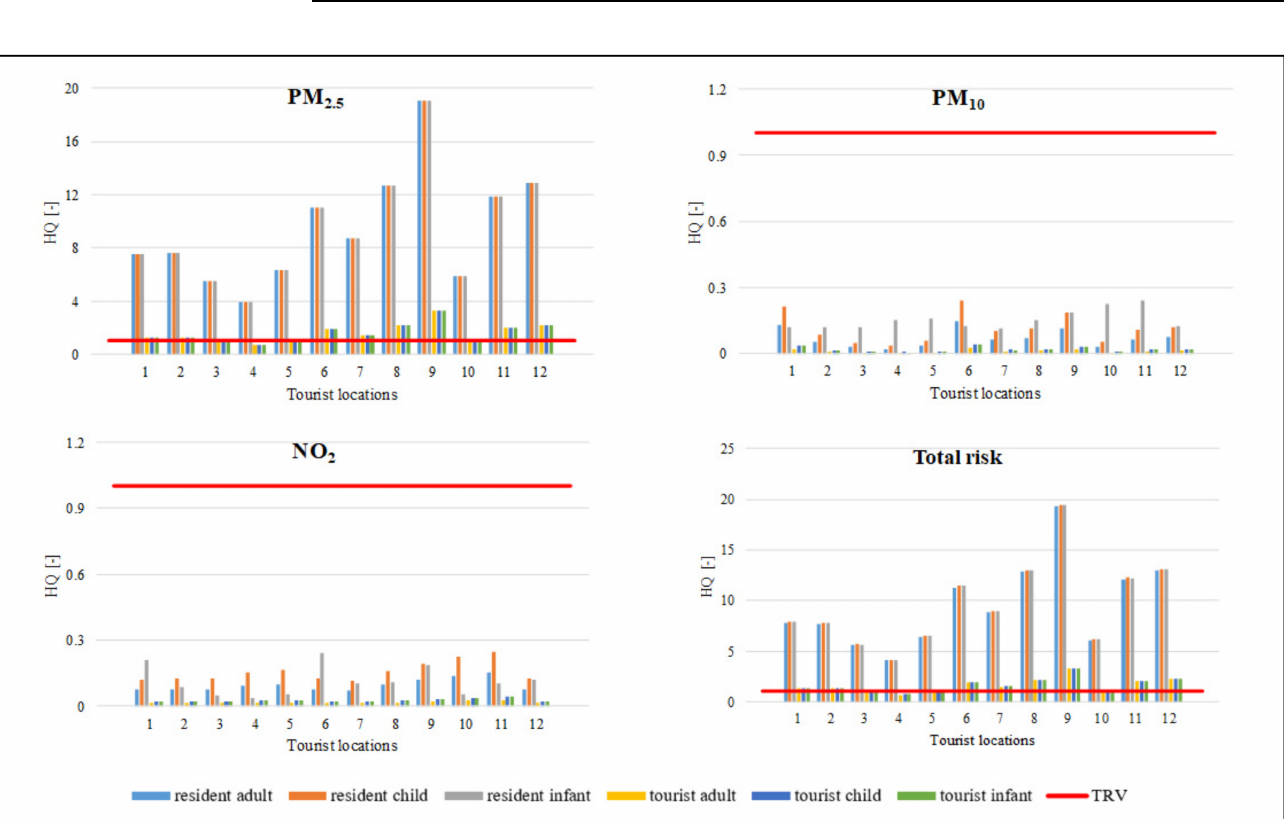
Figure 4. Non-carcinogenic risk values (HQ) for selected air pollutants in the study area (for location numbers, see Figure 2); TRV: target risk